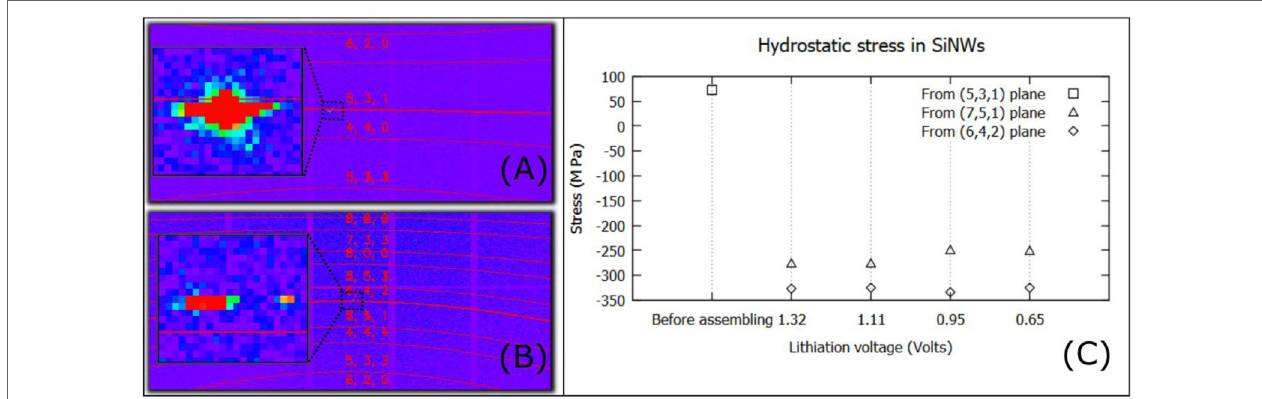
FigUre 3 | (Color online) (a) Before assembling into the battery cell, the single-crystalline silicon nanowires (SiNWs) were scanned by monochromatic beam to obtain Debye–Scherer pattern with theoretical silicon ring positions. The inset shows a zoomed image of diffracted peak from silicon crystal plane of (5, 3, 1) at the energy of 14.08 keV. (B) Debye–Scherer pattern is obtained from diffraction of SiNWs, after they have gone through lithiation from ~3 to 0.65 V. The inset shows a magnified image of diffracted peak from plane (6, 4, 2) at the energy of 14.62 keV. (c) Hydrostatic stress in SiNWs before the assembly of battery cell was determined from a peak, diffracted from (5, 3, 1) crystal plane as shown in (a) . After assembling of battery cell, SiNWs were scanned with two different energy ranges at different levels of lithiation. Two peaks were identified from each energy range corresponding to (7, 5, 1) and (6, 4, 2) crystal planes of the crystalline part of the lithiated SiNWs. The hydrostatic stress measurement using this technique has an experimental uncertainty of about ± 5 MPa (strain resolution was limited by pixel resolution in the hybrid pixel array detector in the synchrotron X-ray microdiffraction setup). Further a representative cycling (discharge) curve was presented in Figure S4 in Supplementary Material with a marking of the salient result data points presented in this